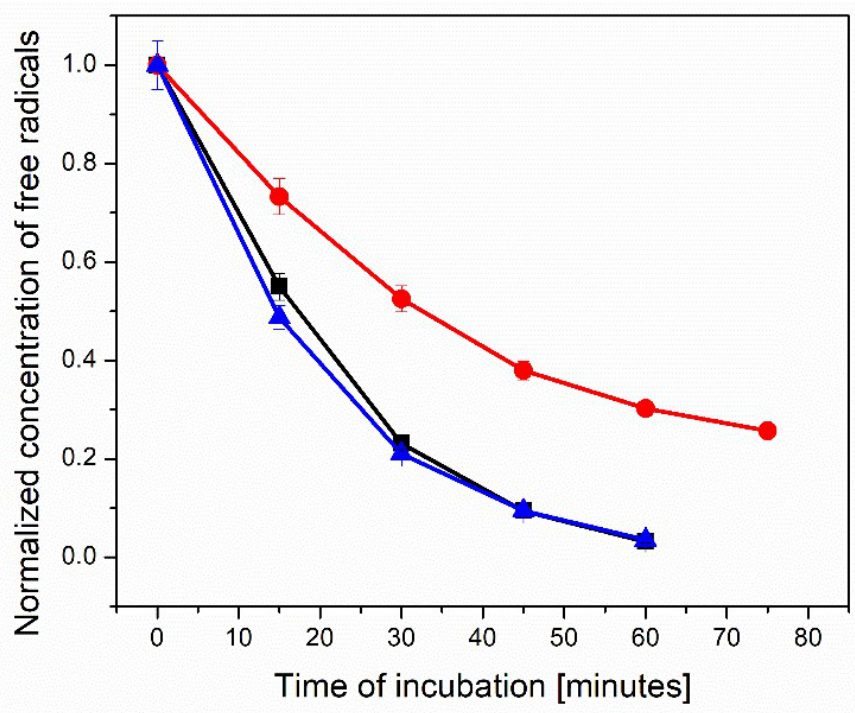
Figure 10. The influence of vitamin C on TEMPO concentration: yeast cells with TEMPO and vitamin C ( ■ ), TEMPO with vitamin C (•), and yeast cells with TEMPO ( ▲ ).